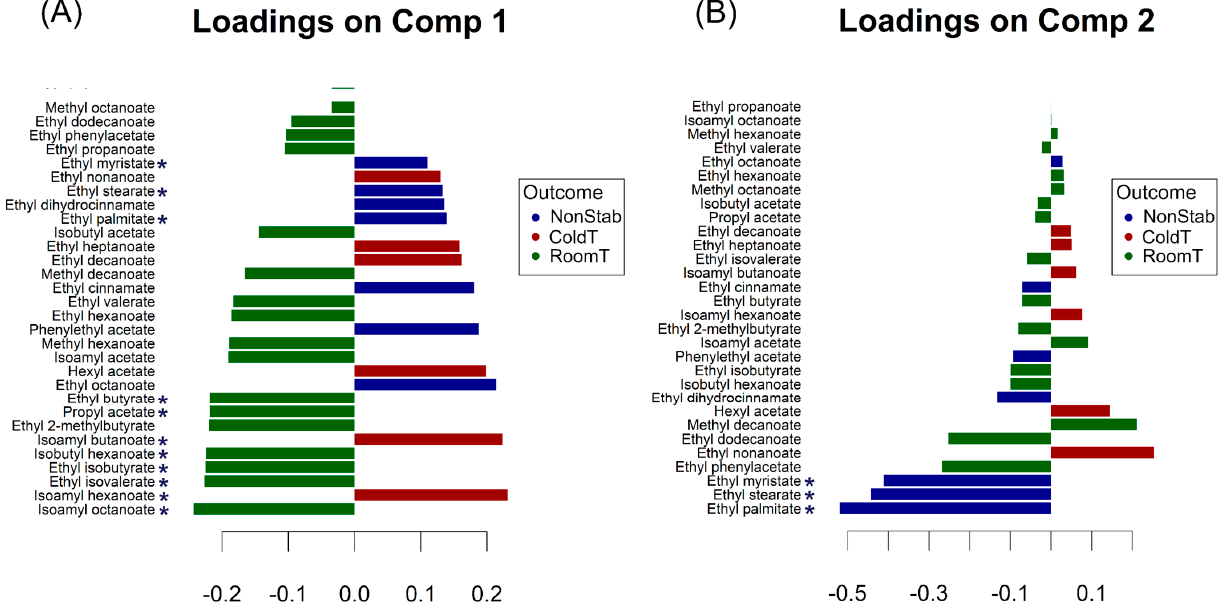
Figure 5. Loadings contribution barplot on component 1 ( A ) and component 2 ( B ) of the multilevel partial least squares discriminant analysis (ML-PLS-DA) carried out to discriminate between brandy samples before and after cold stabilization and filtration. Color indicates the class for which the compound had a maximal mean value. Bar length represents the multivariate regression coefficient, with either a positive or negative sign for that particular feature of each component, i.e., the im- portance of each variable in the model. NonStab: non-stabilized brandies; ColdT: brandy stabilized at cold temperature; RoomT: brandy stabilized at room temperature. An asterisk highlights the most discriminative compounds selected during a variable reduction procedure (i.e., potential markers related with the stabilization method). Table 1. Multilevel partial least squares discriminant analysis (ML-PLS-DA) performance (from a double cross-validation scheme).